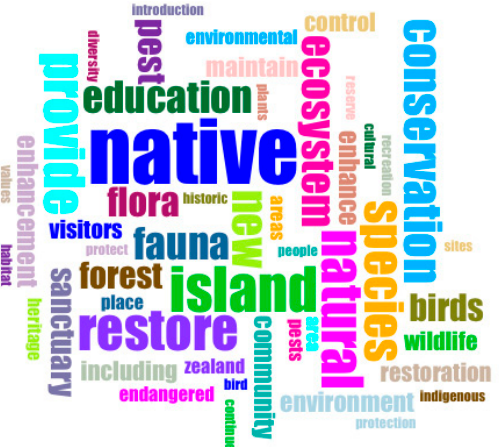
Figure 2. Visualisation of the dominant words in the goals and objectives of 50 community groups participating in ecological restoration projects. Word size reflects frequency of occurrence.